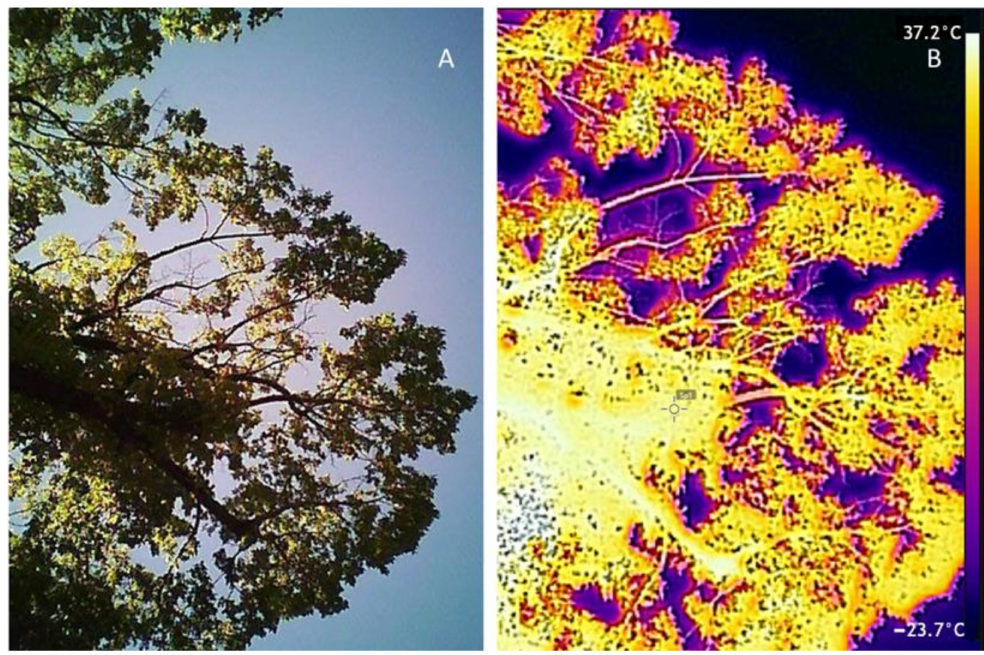
Figure 3. Example of a visible (RGB) image ( A ) and the corresponding infrared thermal image ( B ) from an Elm tree taken using the integrated camera on top of a moving vehicle. The pre-processing of the RGB images consisted of the binarization (Figure 4A) using the blue channel from the RGB images by selecting the lowest part of the histogram curve (valley) detected automatically between the pixels corresponding to the canopy material (first peak) and the background or sky (second peak) (Figure 4B). After binarization, each image was automatically subdivided into a 5 × 5 sub-images to perform gap